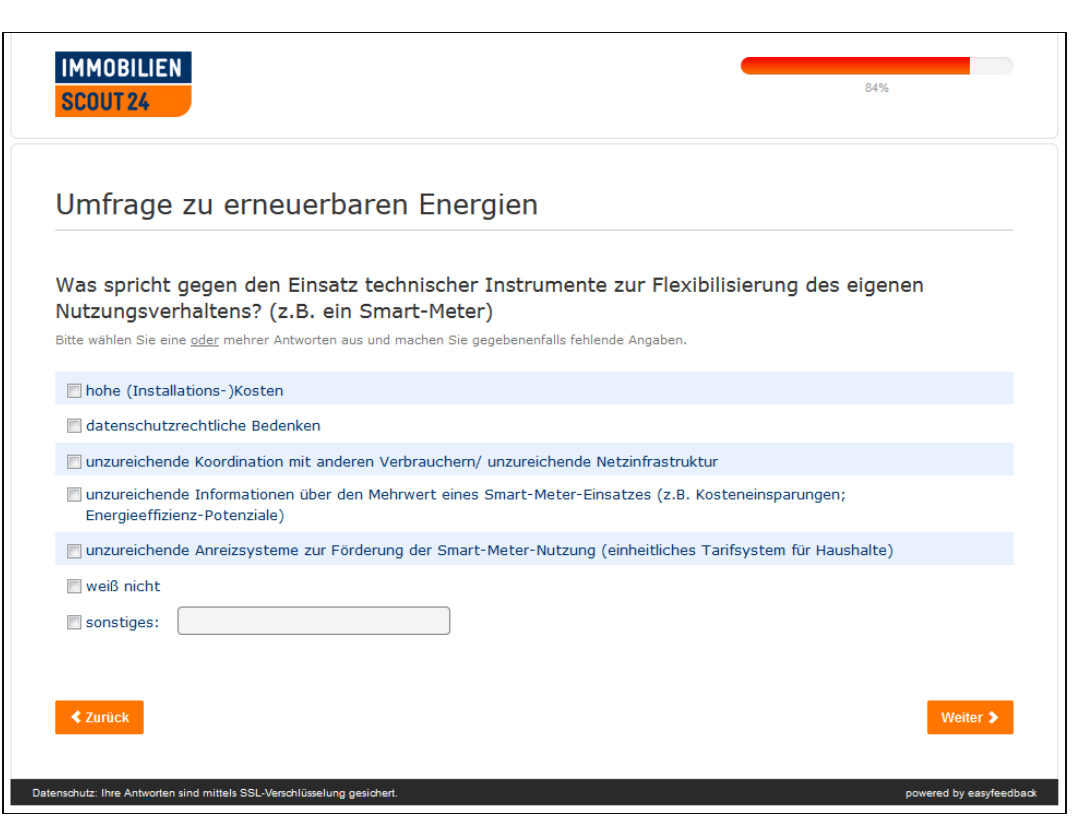
Figure A14. Screenshot of Questionnaire Page 13.